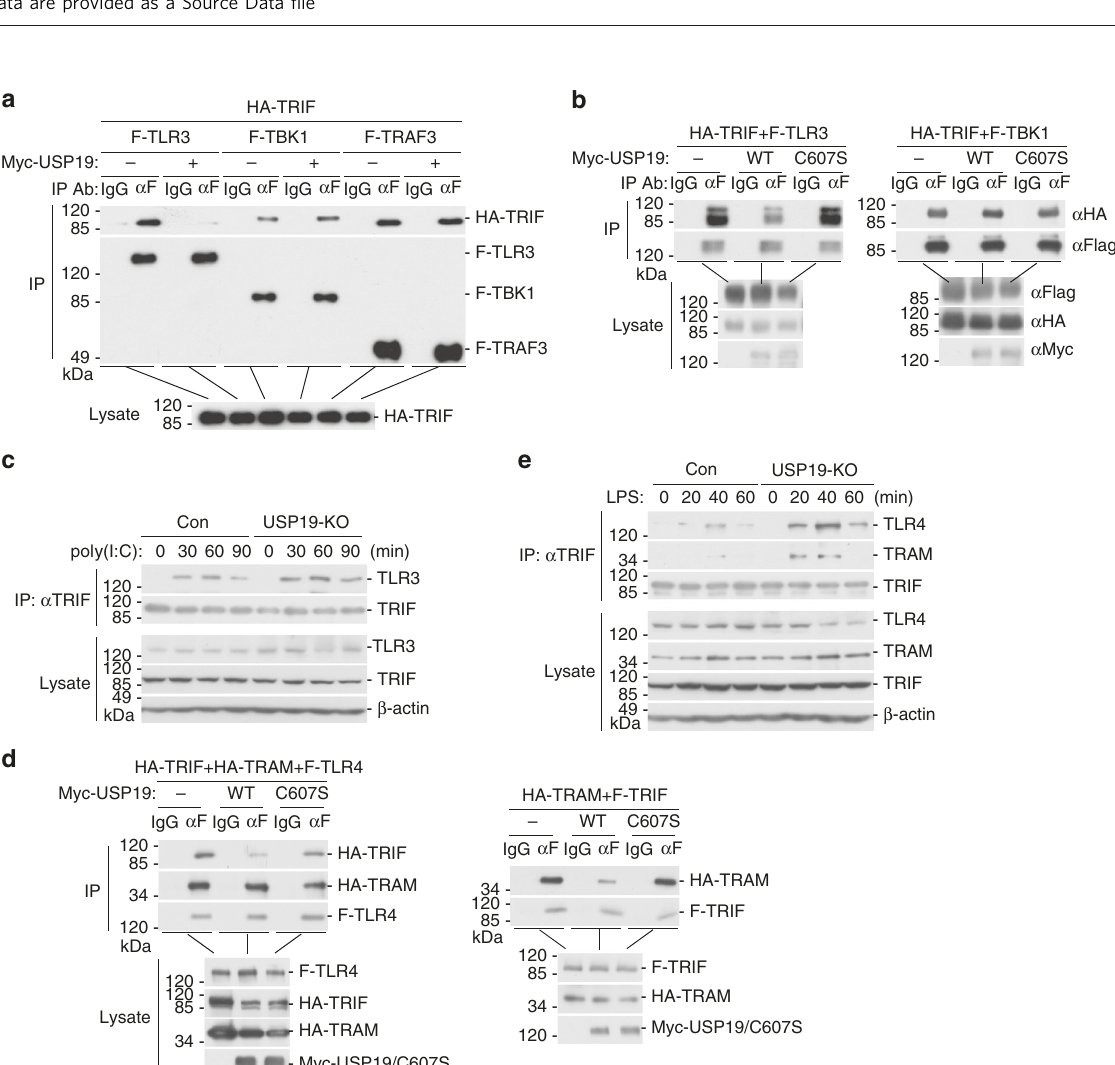
Fig. 5 USP19 removes K27-linked polyubiquitin moieties from TRIF. a USP19 but not its C607S mutant deubiquitinates TRIF. HEK293 cells were transfected with HA-TRIF and Myc-Ub together with empty vector, Flag-USP19 or Flag-USP19(CS). Twenty hours after transfection, ubiquitination assays were performed with the indicated antibodies. The detailed information of ubiquitination assays is described in the Methods. b USP19-de fi ciency potentiates polyubiquitination of TRIF after poly(I:C) and LPS stimulation. Usp19 + / + and Usp19 − / − BMDMs were left untreated or treated with poly(I:C) (100 μ g/ml) or LPS (100 ng/ml) respectively for the indicated times. Cell lysates were immunoprecipitated with anti-TRIF. The immunoprecipitates and lysates were analyzed by immunoblotting with the indicated antibodies. c Overexpression of USP19 removes K27-linked polyubiquitin moieties from TRIF. HEK293 cells were transfected with Flag-TRIF, Myc-USP19, HA-ubiquitin or its mutants (KO, K-only; KR, K is mutated to R) together with a control and USP19 expression plasmid for 24 h before ubiquitination assays with the indicated antibodies. d USP19-de fi ciency potentiates poly(I:C)- and LPS-induced K27-linked polyubiquitination of TRIF. The 293-TLR3 cells or 293-TLR4 cells were left untreated or treated with poly(I:C) (100 μ g/ml) or LPS (100 ng/ml) respectively for the indicated times before ubiquitination assays with the indicated antibodies. Data are representative of two or three experiments with similar results. Source data are provided as a Source Data fi le